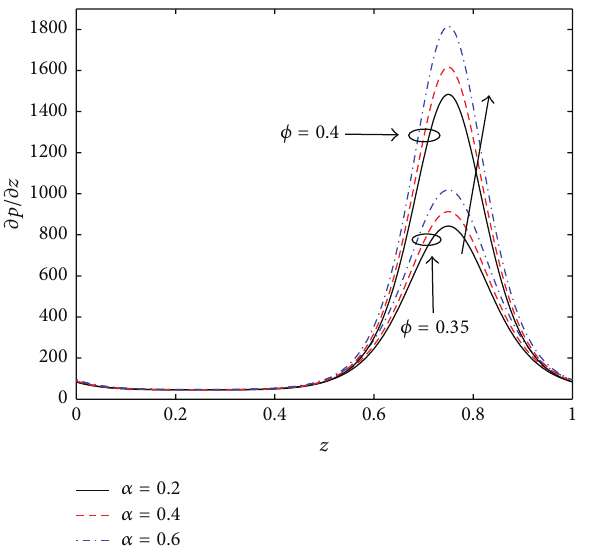
Figure 3: Pressure gradient 𝜕𝑝/𝜕𝑧 versus axial distance 𝑧 for differ- ent values of the parameter 𝛼 1 and amplitude ratio 𝜙 with 𝑄 = −2 , Gr = 3 , 𝜀 = 0.35 , 𝛽 = 10 , 𝜆 1 = 1 , and 𝑡 = 1 .